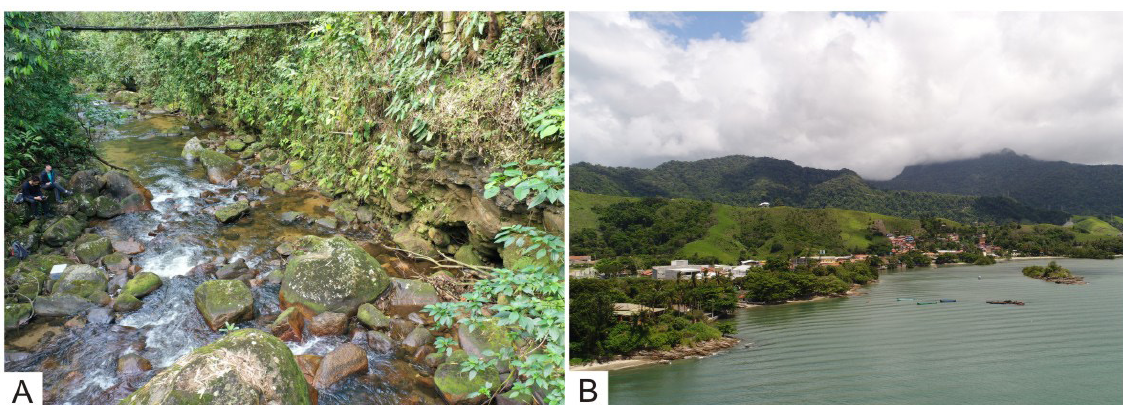
Figure 4. A) Geosite “Records of the 1967’s Catastrophe of Caraguatatuba”, in the homonymous town. The pebble deposits on the bank and the poorly sorted boulders along the river’s course record landslides that were responsible for a great disaster in the town; B) Geosite “Dykes of Ponta do Araçá”, in São Sebastião. The rocky shores (lower left) are composed of both alkaline and basaltic dikes related to the breakup of Gondwana that constitute important geoheritage. The bay sustains a mangrove ecosystem that provides habitats for several species and benefits local